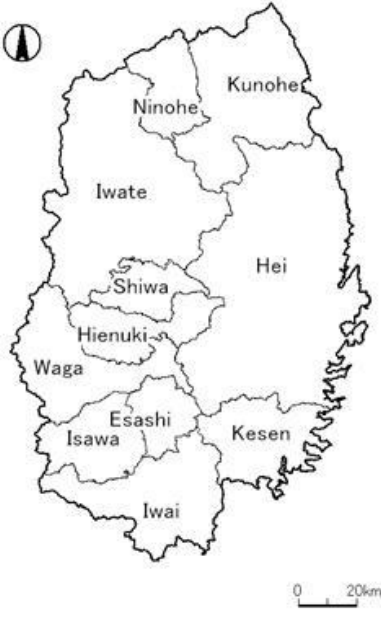
Figure 3. Counties in Iwate Prefecture in the 1870s.